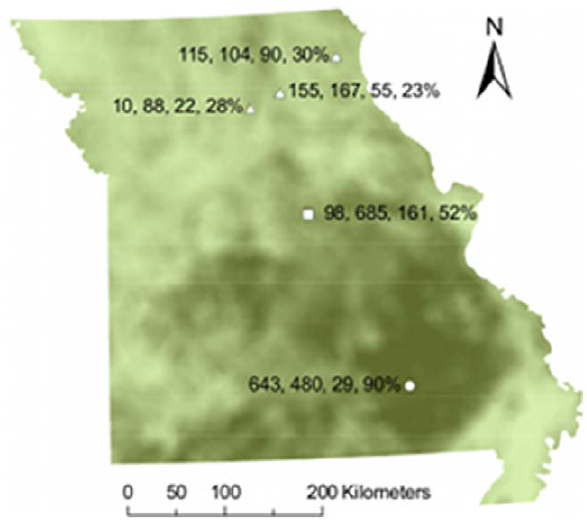
Figure 2. Study locations. Locations of REAM (triangles), Baskett (square), and MOFEP (circle) sites in a study of temporal trends of brood parasitism and nest survival in Missouri, USA, 1991–2009. Shading indicates percent forest cover in a 10-km radius, with darker shading indicating more forest (range: , 1–97%). Numbers next to each site indicate number of nests used in nest survival analysis for Acadian Flycatchers, Indigo Buntings, and Northern Cardinals, respectively, and the mean percent forest cover for nests at each site. 10-km buffers surrounding nests that changed to or from forest to calculate the percent change in forest cover.